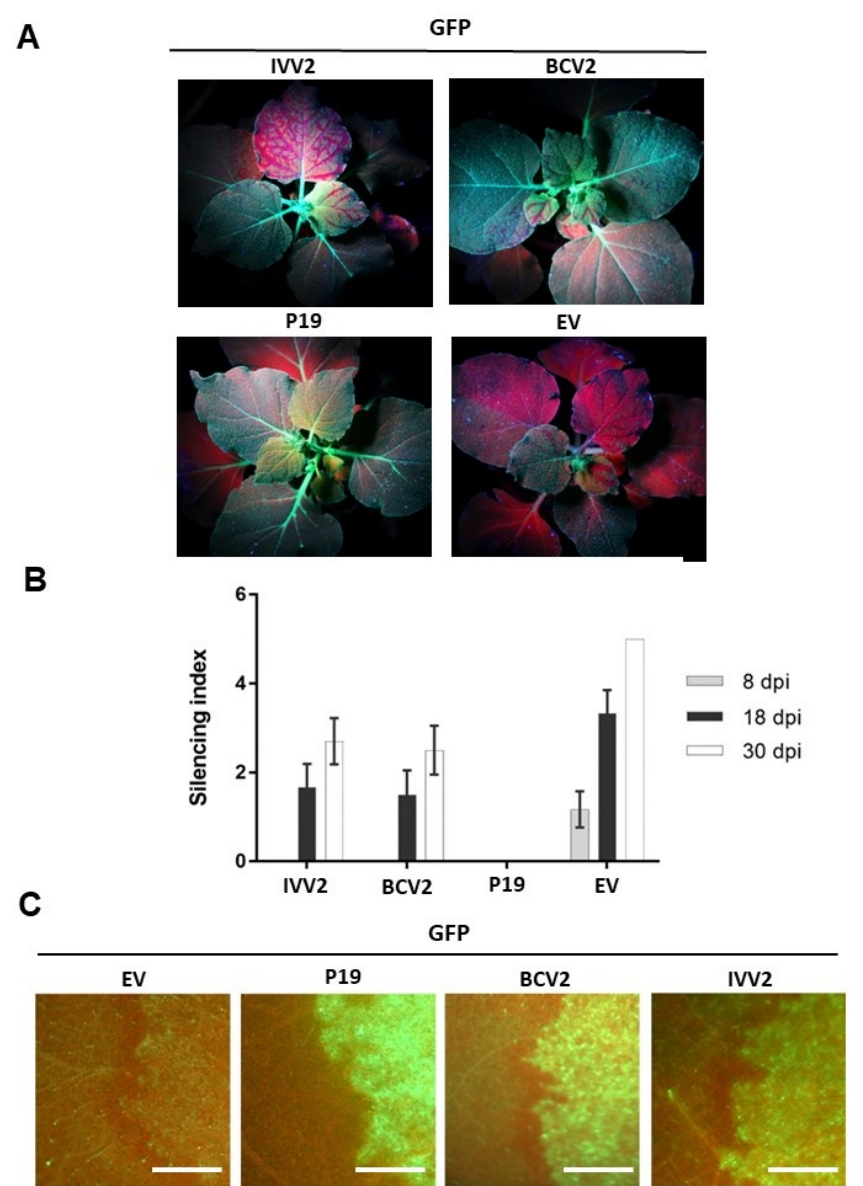
Figure 3. Effect of V2 from beet curly top Iran virus on long distance and short range spread of RNA silencing in 16c Nicotiana benthamiana plants. ( A ) 16c plants were agroinfiltrated with two A. tumefaciens cultures expressing GFP and V2 from beet curly top Iran virus (IVV2). V2 from beet curly top virus (BCV2), P19, and the empty vector (EV) were used as controls. Agroinfiltrated 16 c plants were observed under UV light at 18 days post inoculation (dpi). ( B ) Levels of systemic silencing (silencing index) of these plants at 8-, 18-, and 30-days post infiltration (dpi). Silencing index ranges from 0 (no silenced leaves) to 5 (plant with all the leaves silenced). Values correspond to the average of six plants. Bars represent standard deviation. ( C ) GFP expression in the cells surrounding the agroinfiltrated area at 6 dpi. Barr: 2 mm. Four to six plants were agroinfiltrated per experiment. Similar results were obtained in three independent